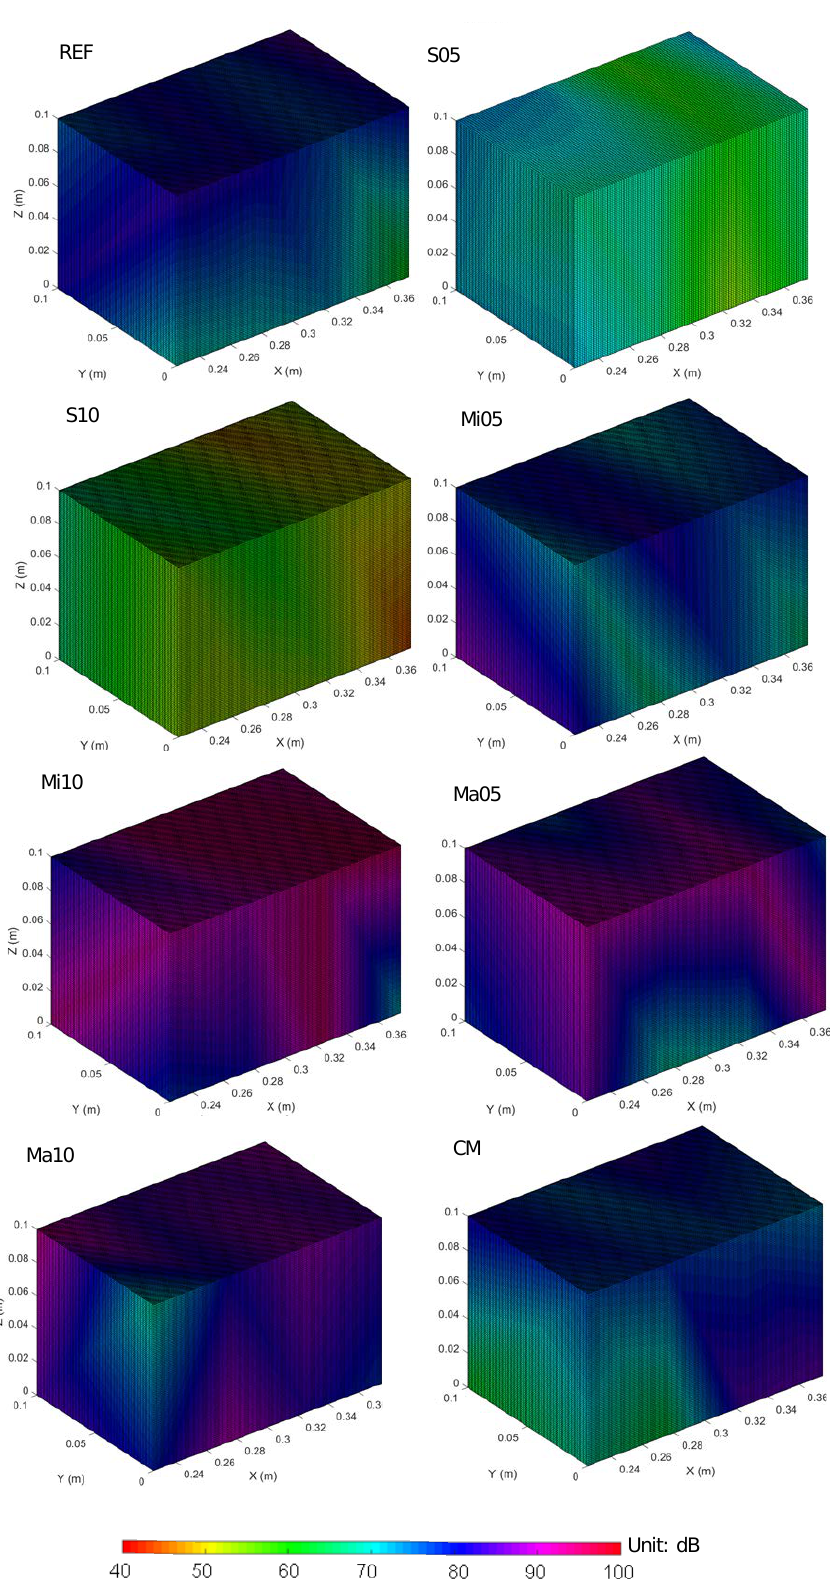
Figure 5. Three-dimensional contour maps of amplitude values recorded by the S6 sensor of the 24 V artificial acoustic source.